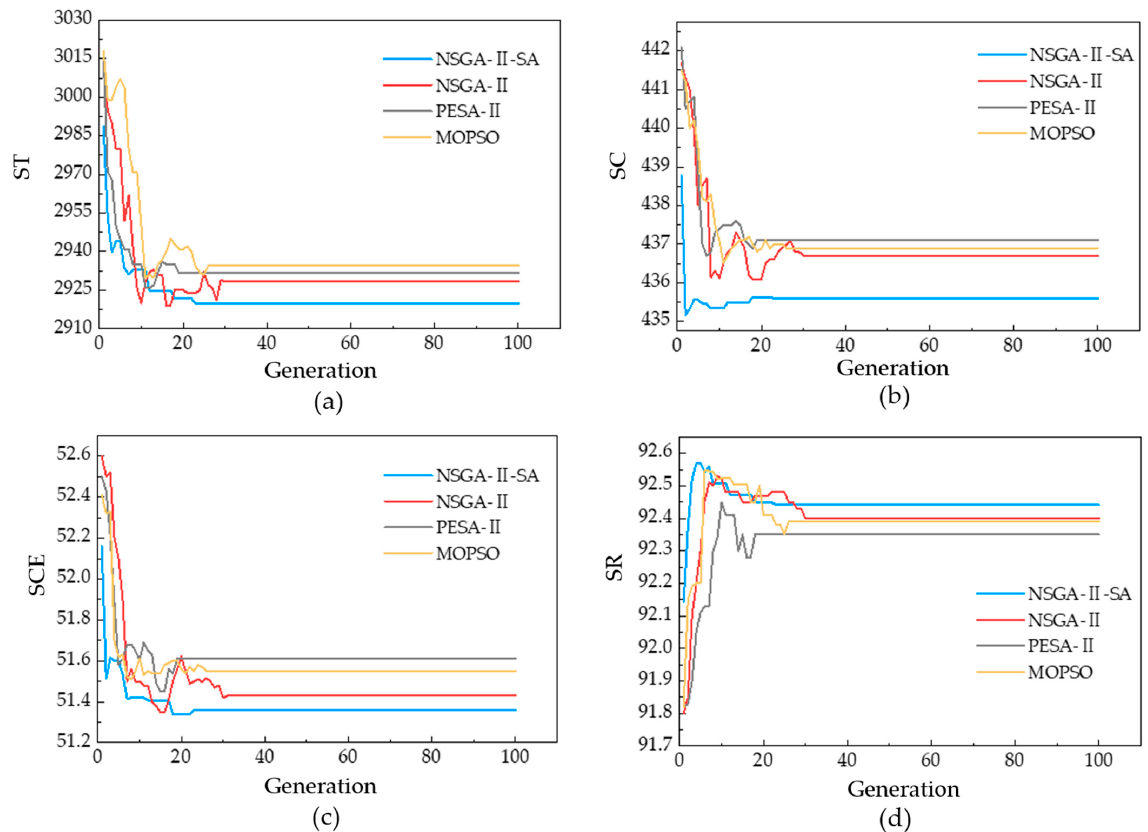
Figure 9. ( a ) Iteration curves in service time dimension; ( b ) Iteration curves in service cost dimen- Figure 9. (a) Iteration curves in service time dimension; (b) Iteration curves in service cost di- mension; (c) Iteration curves in service carbon emissions dimension; (d) Iteration curves in ser- sion; ( c ) Iteration curves in service carbon emissions dimension; ( d ) Iteration curves in service vice cost dimension. cost